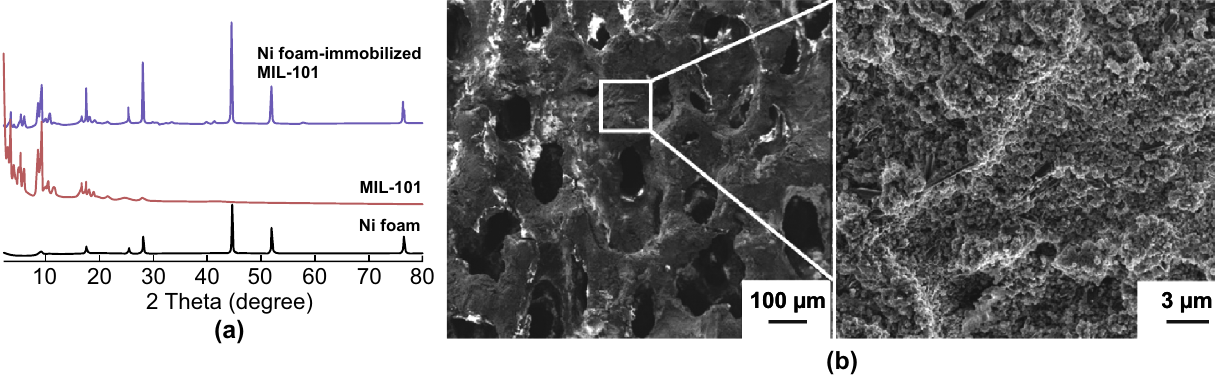
Fig. 4 a PXRD patterns of Ni foam-immobilised MIL-101(Cr) (blue) showing the presence of peaks which correspond to both Ni foam (black) and MIL-101(Cr) nanocrystals (red). b SEM images of Ni foam-immobilised MIL-101(Cr) showing the presence of multi-layered MIL-101(Cr) nanocrystals on the macroporous Ni foam. Reprinted with permission from Ref. [60]. Copyright 2015 Elsevier B.V. (Color figure